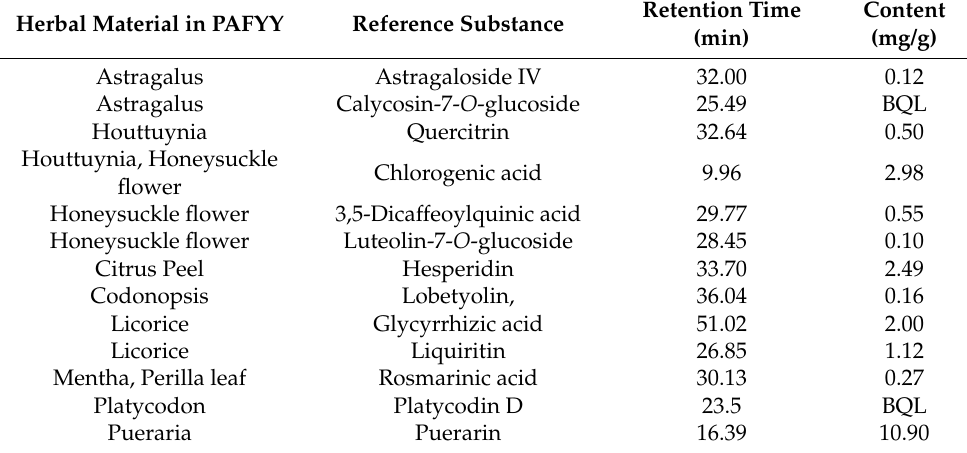
Figure 2. Chromatographic fingerprints of PAFYY from 3D-HPLC/PDA. Table 1. Herbal content and retention time of 11 components in PAFYY.